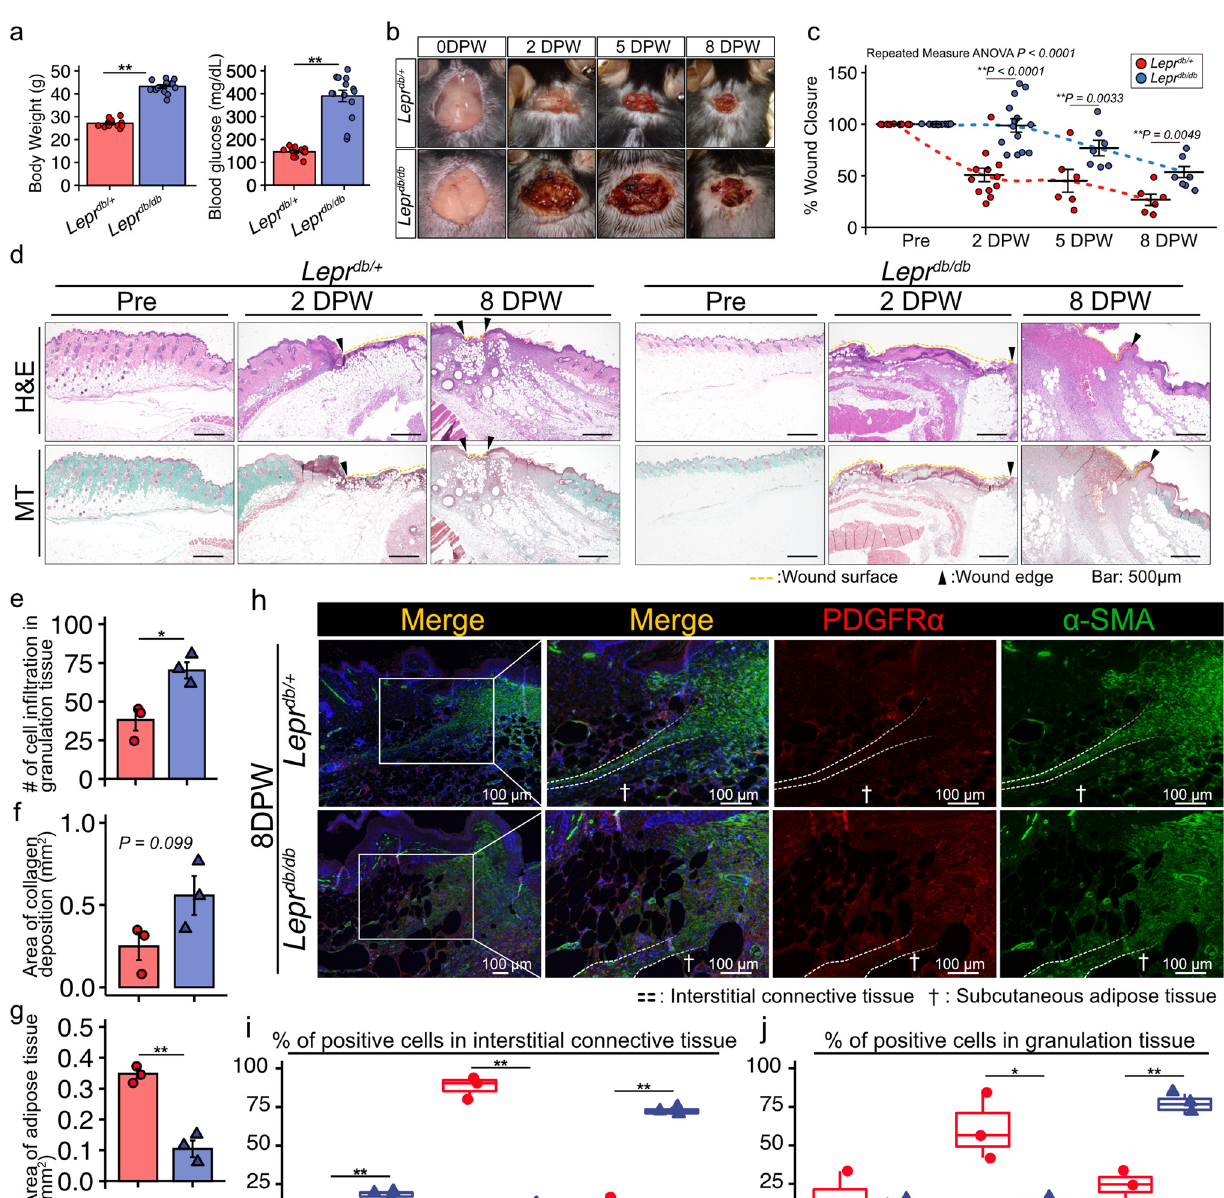
Fig. 1 Lepr db/db mice exhibit impaired wound healing. a Body weight and blood glucose levels for Lepr db/ + and Lper db/db mice before full-thickness excisional skin wounds were created ( n = 12 for Lepr db/ + and n = 14 for Lper db/db mice). b Representative wound images during the healing process and ( c ) the wound area, reported as the percent of wound closure compared to the 0 days post wound (0 DPW) area ( n = 12 for Lepr db/ + 0 and 2 DPW, n = 6 for Lepr db/ + 5 and 8 DPW , n = 14 for Lper db/db 0 and 2 DPW, and n = 7 for Lepr db/db 5 and 8 DPW). d Representative images of H&E staining and Masson trichrome (MT) staining of a wound at pre-wounding, 2 DPW, and 8 DPW. e Quantitative data concerning the number of in fi ltrated cells. f Area covered by collagen deposits. g Area covered by adipose tissue ( n = 3 for each group). h – j Representative images of a wound at 8 DPW following immunostaining for PDGFR α and α -SMA ( h ), and percentage of cells positive for either PDGFR α , α -SMA, or both in interstitial connective tissue ( i ) and in granulation tissue ( j ) ( n = 3 for each group). Quantitative data are shown as means± SE in dot plots or box-and-whisker plots with IQRs and 1.5 times the IQR. p -values were determined using either a two-tailed Student ’ s t -test or the Tukey method for one-way ANOVA (* p < 0.05 and ** p <